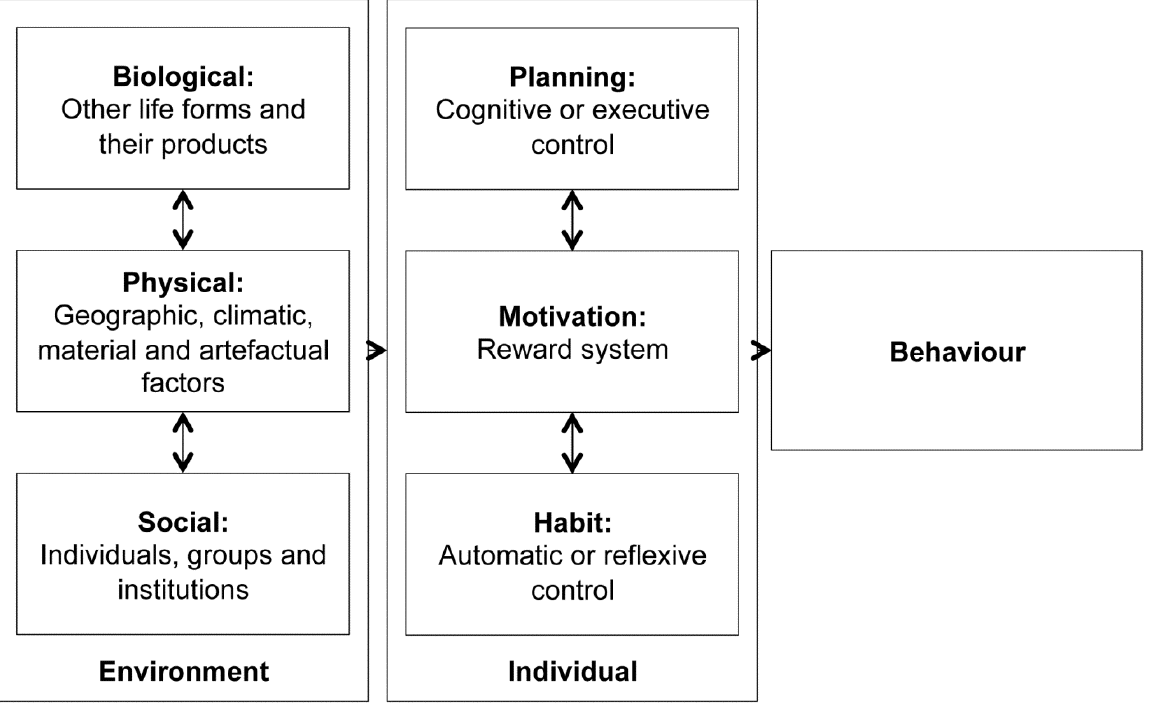
Figure 2. Conceptual framework of the determinants of defecation and anal cleansing